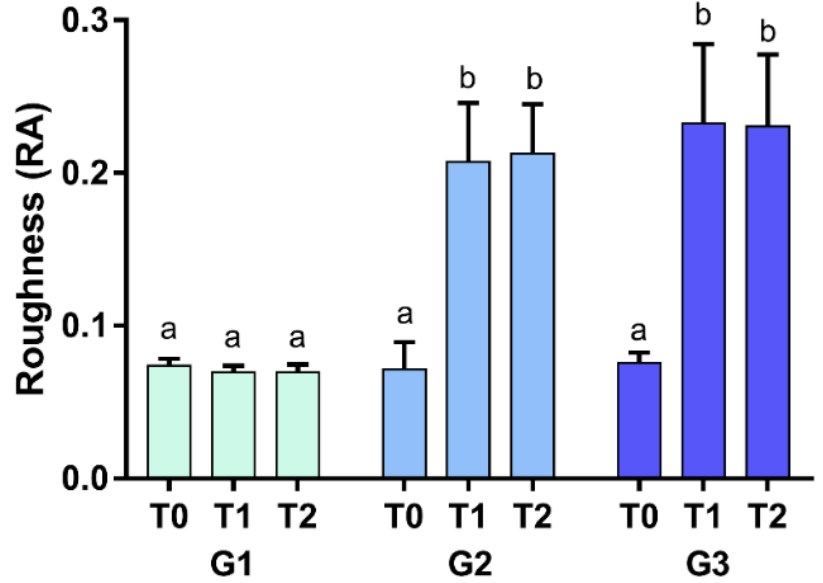
Figure 2. The mean ± standard deviations of the surface roughness submitted to two-way analysis of variance for repeated measurements according to the periods for the groups tested. Different lowercase letters indicate an intragroup statistically significant difference.